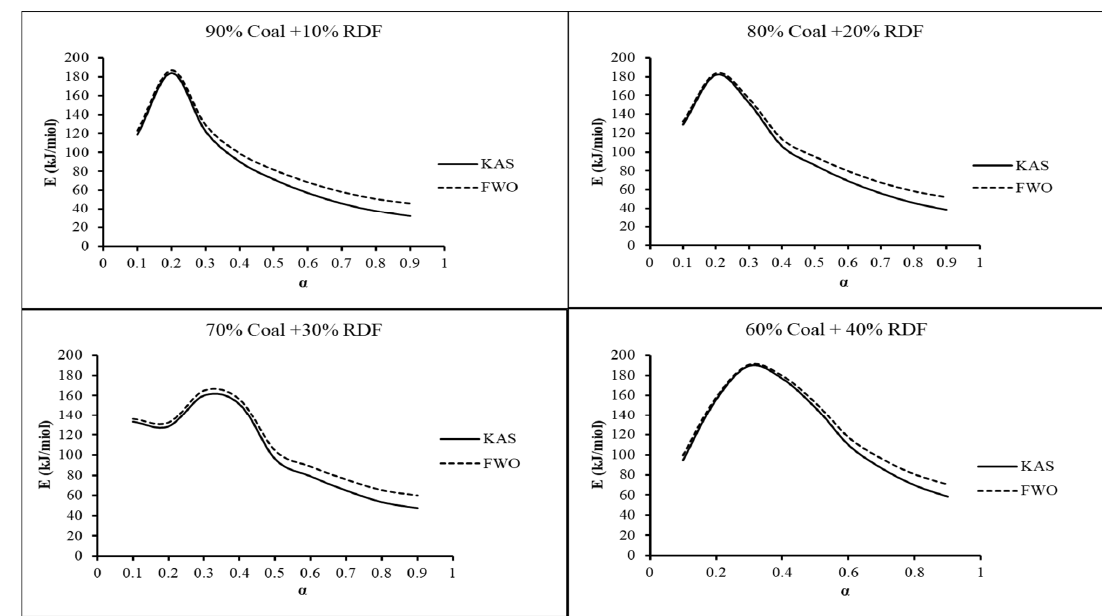
Figure 5. Relationship between E and α for coal and RDF blends by KAS and FWO methods .